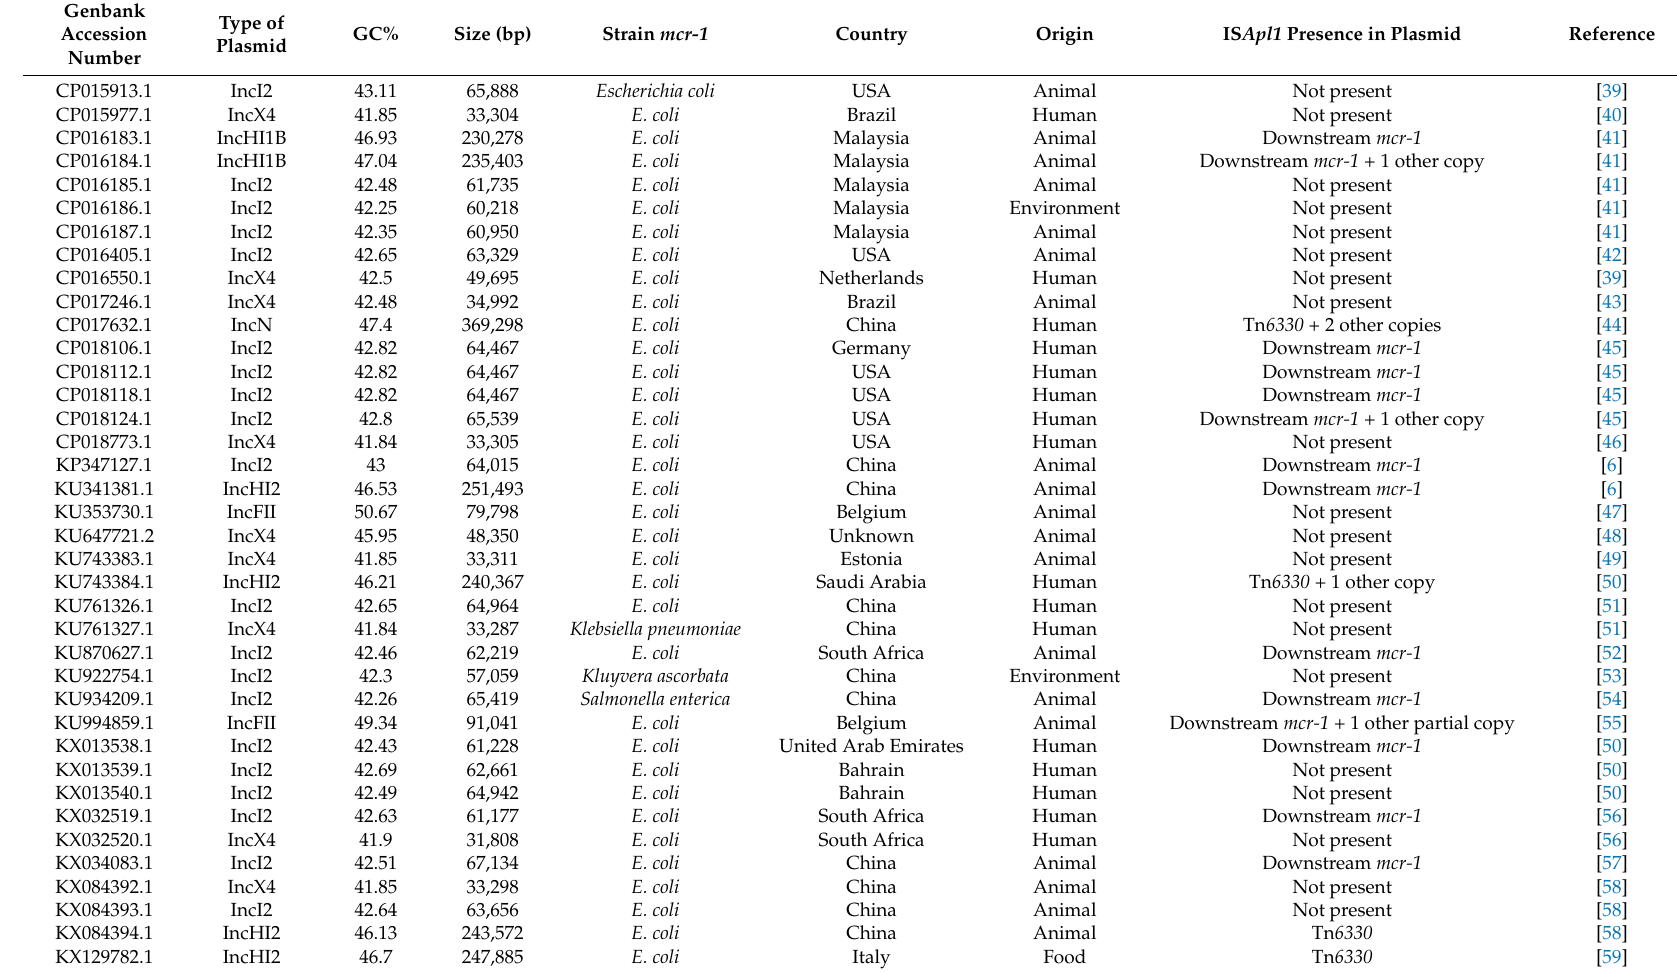
Table 2. IS Apl1 presence, plasmid types and origins of mcr-1 plasmids that were included in our